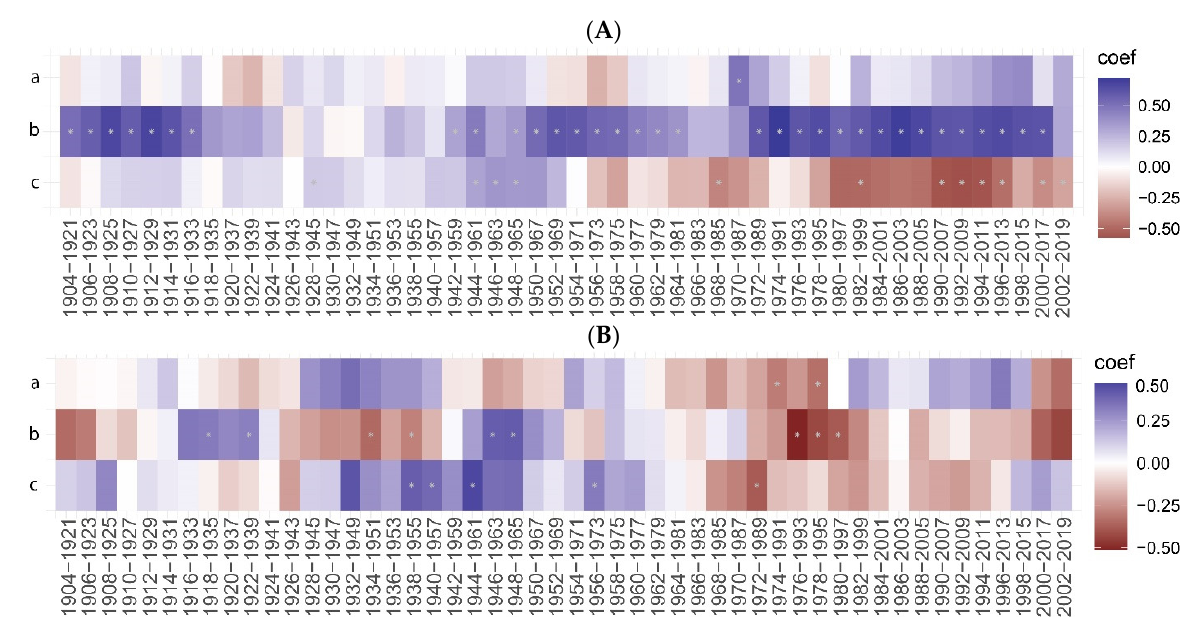
Figure 8. Running correlation analysis with an 18-year window and 2-year step shows ( a ) previous autumn, ( b ) current summer and ( c ) current spring intervals between the tree ring growth rate and ( A ) temperature and ( B ) precipitation. Correlation is depicted by colors. * = significant p < 0.05.